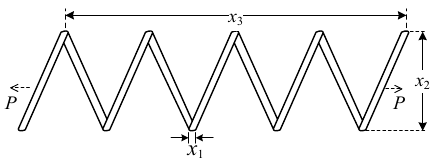
Figure 11. Tension string design.